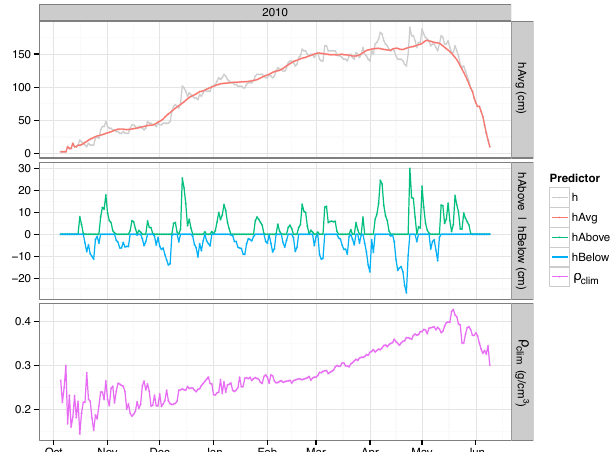
Fig. 4. Predictor variables for a new model of daily bulk density. Example for Lake Irene SNOTEL site in 2010. The observed snow depth time series, h , is not used as a predictor but is transformed into three components. Long-range variability, h Avg, is shown in the top panel. Positive, h Above, and negative, hBelow, anomalies of the observed time series, h , from h Avg describe short-range variability. The sum of these three new predictors equals h . The bottom panel shows the density climatology of fit, ρ clim , which is derived from neighboring SNOTEL sites and used for both fit and